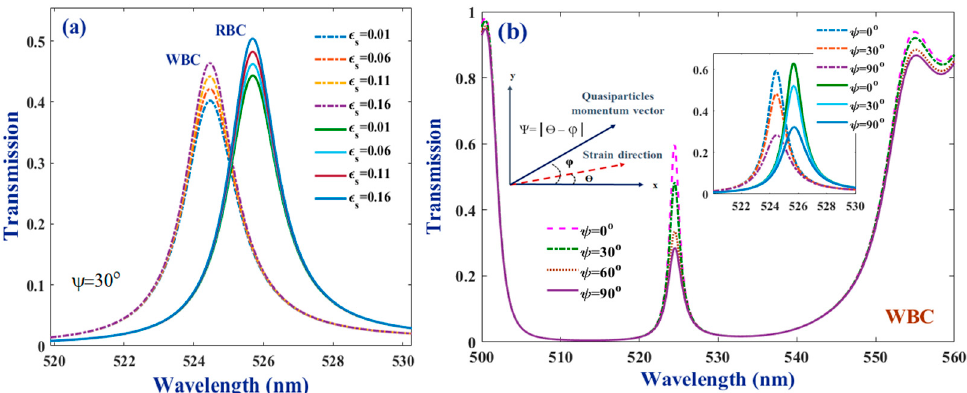
Figure 6. ( a ) Resonant modes of the WBC and RBC samples for different values of Ɛ s at ψ = 30 ° ; ( b ) transmittance spectra of the WBC sample for different values of ψ degree, at a fixed value of Ɛ s = 0.2. Insets are presenting how ψ is defined and how resonant modes for the WBC and RBC samples depend on the ψ degree at Ɛ s = 0.2. Other parameters are considered, as presented in captions of Figures 2 and 5.